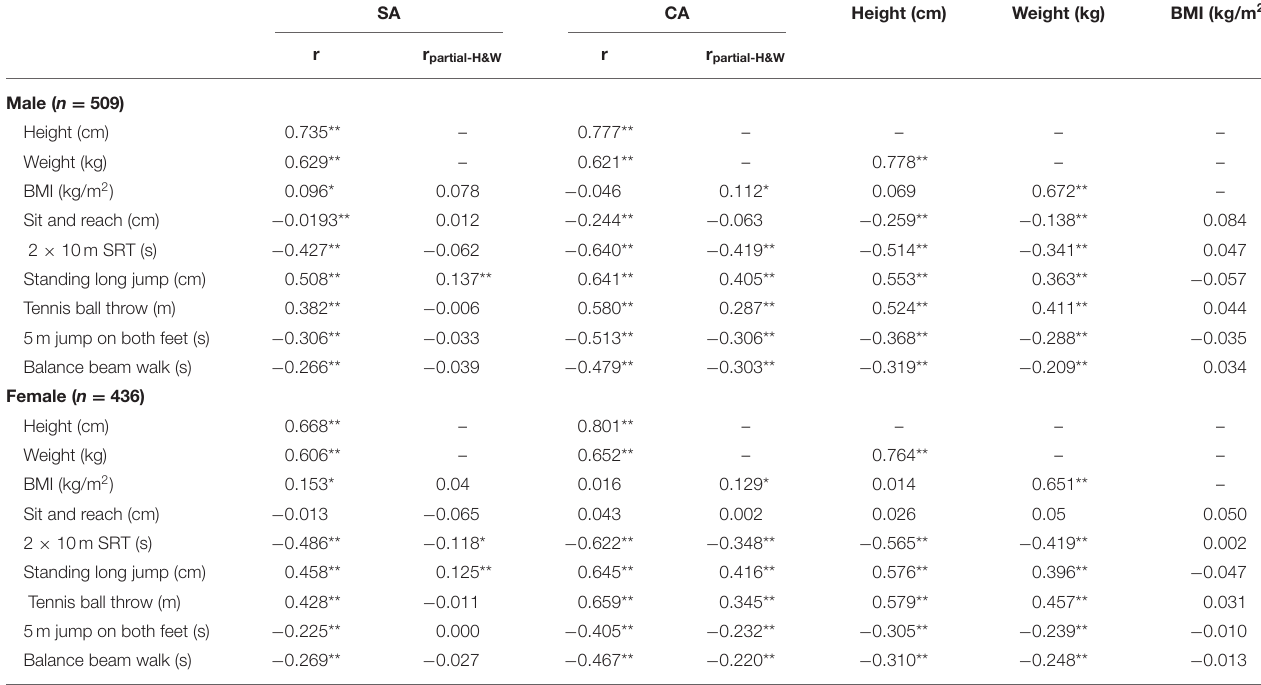
TABLE 2 | Correlations and partial correlations between skeletal age, chronological age, and body size, physical fitness in children aged 3–6 years old.